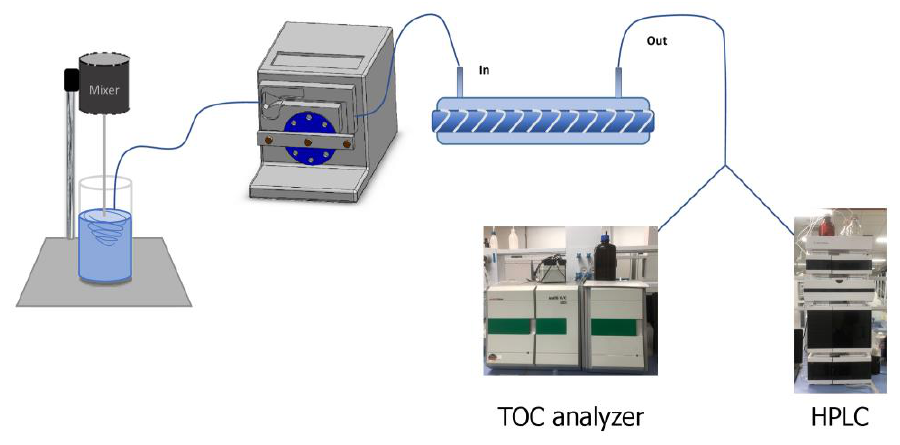
Figure 4. Experimental setup for CFPR.